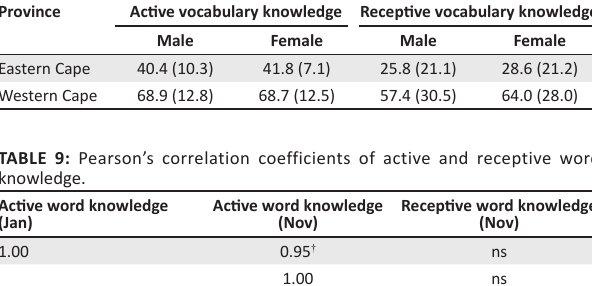
TABLE 8: Active and receptive vocabulary knowledge (mean % and SE) as measured in November . Province